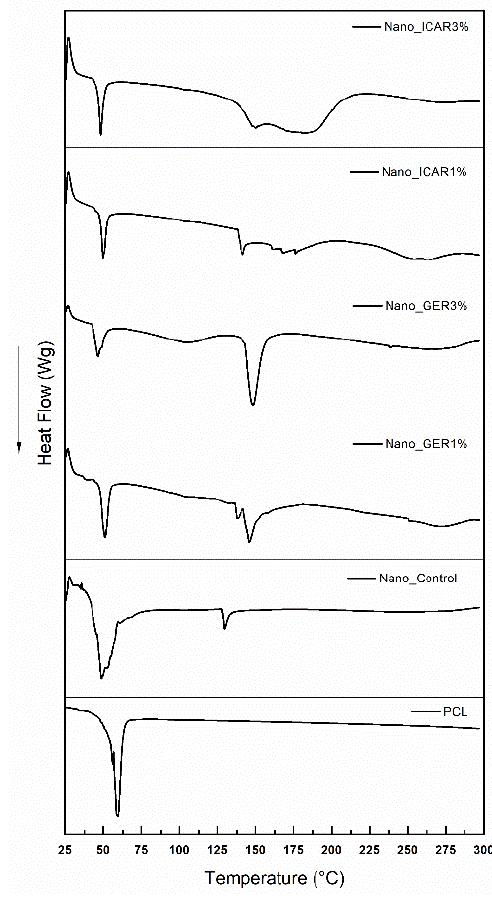
Figure 5. Differential exploratory calorimetry thermograms for: Nano_Control, Nano_GER1%, Nano_GER3%, Nano_ICAR1%, Nano_ICAR3%, and PCL.